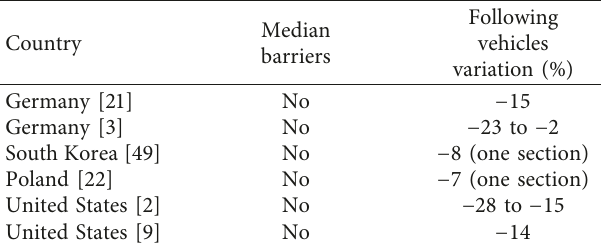
Table 8: Comparison of percentage of following vehicles on